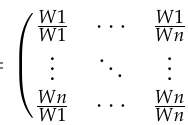
Figure 2. Hierarchical single sort solution